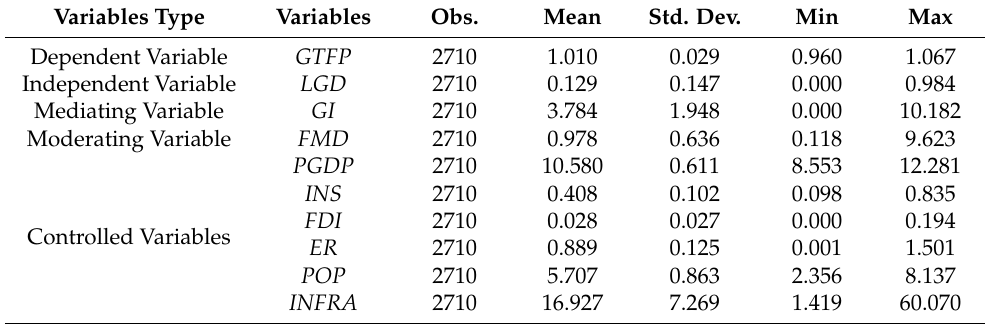
Table 2. Descriptive